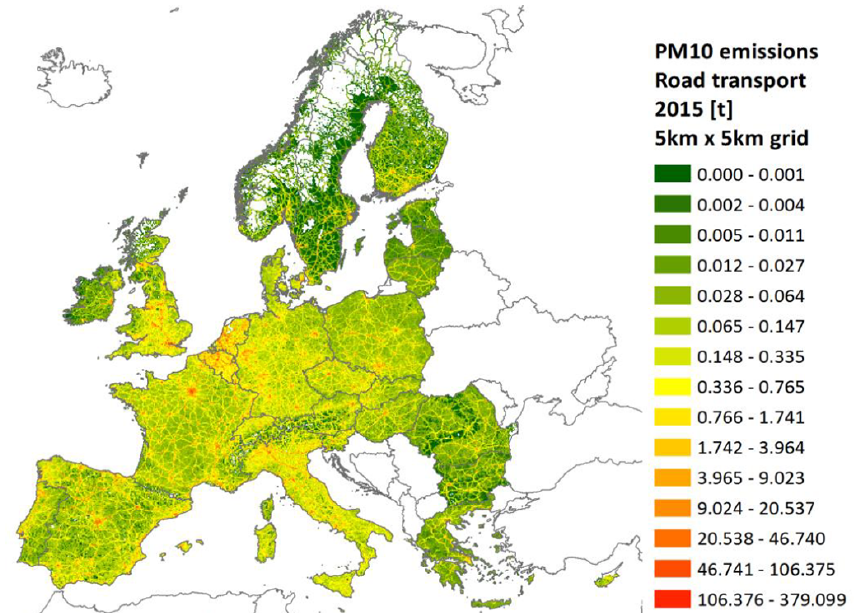
Figure 3. Spatial distribution of national PM 10 emissions from road transport in the EU28 on a 5km × 5km grid (Schmid, 2018).